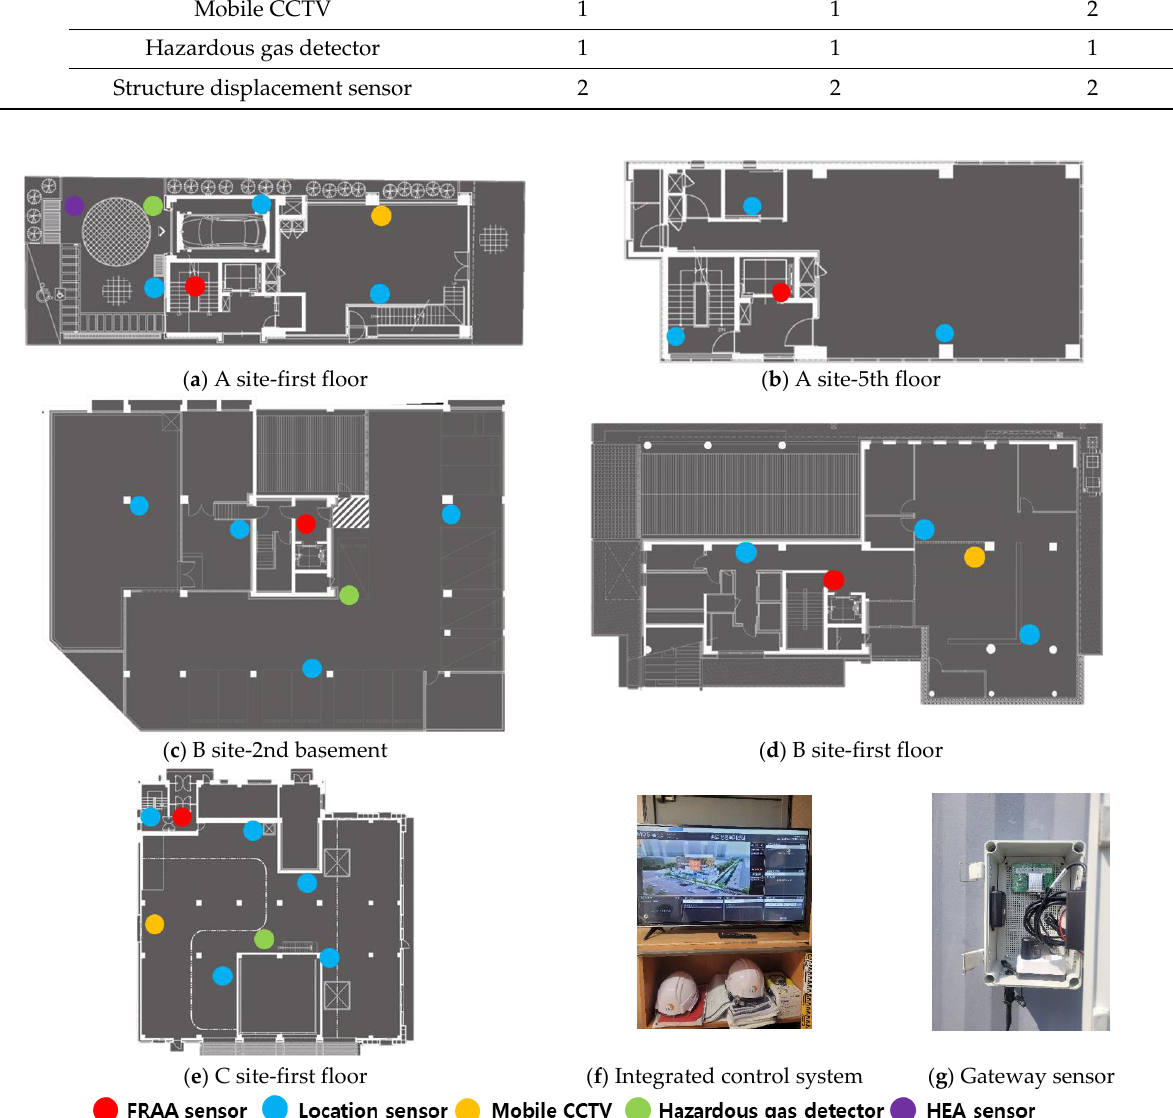
Figure 6. Site-specific sensor installation location and basic installation